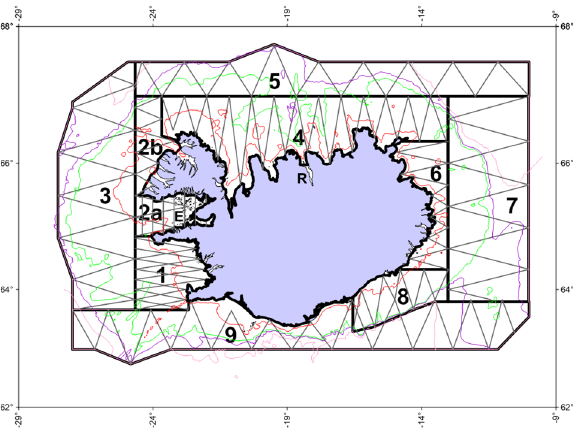
Figure 1. Planned survey design for the 2007 aerial survey around Iceland. The numbers identify the strata, the letters the fjords (see Table 1). Isobaths shown are (in m) 100 (red), 300 (green), 500 (purple) and 1,000 (pink).